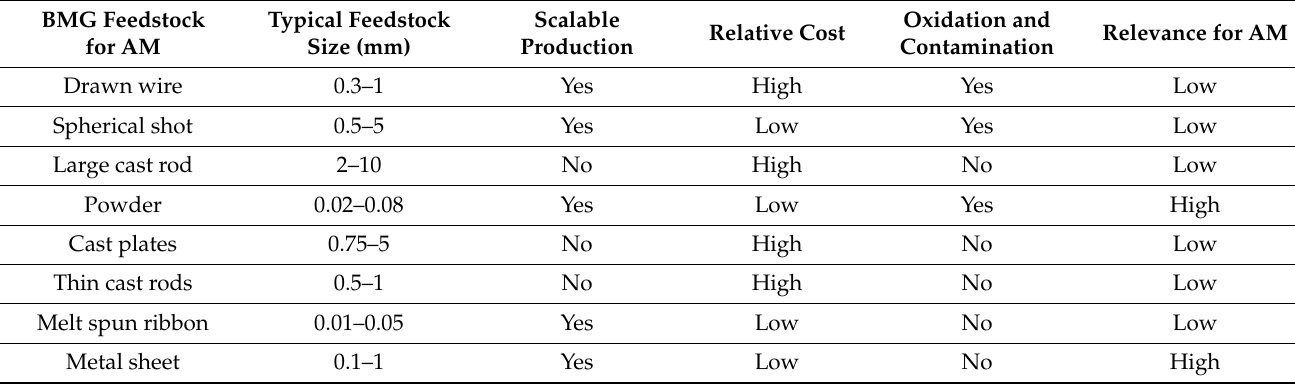
Figure 4. Different types of MG feedstock used in AM technologies: ( a ) wire, ( b ) pellets, ( c ) thick cast rods of various diameters, ( d ) powder, ( e ) cast plates, ( f ) thin cast rods, ( g ) ingot, ( h ) melt spun ribbon, and ( i ) melt spun metal sheet. Reproduced from [28], with permission from Elsevier, 2021. Table 1. Benefits and short comings of various types of feedstock for AM technologies. Reproduced from [28], with permission from Elsevier,